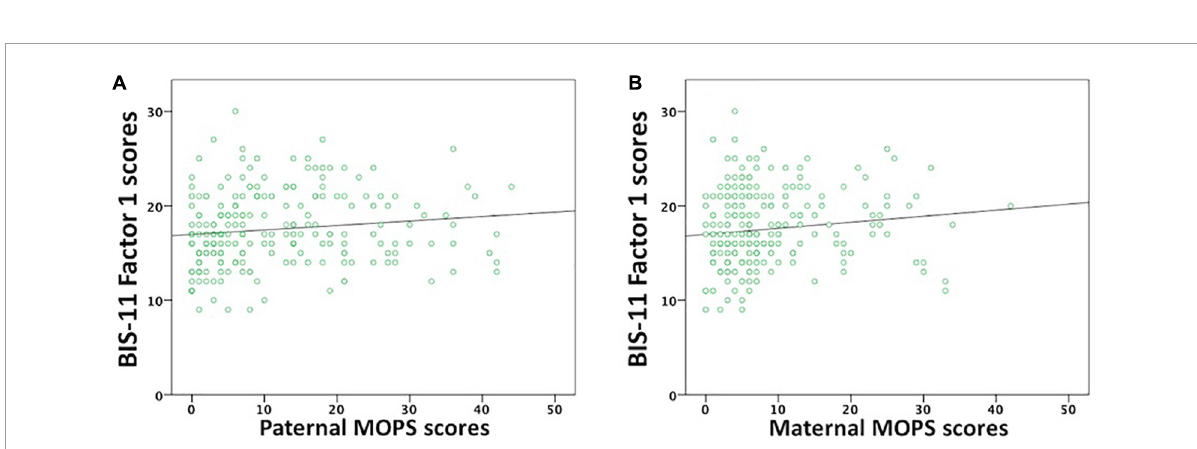
FIGURE2 Correlations between BIS-11 cognitive/attentive (Factor 1) and both Paternal and Maternal MOPS scores. BIS-11 cognitive/attentive scores significantly correlated with (A) Paternal MOPS scores, but not with (B) Maternal MOPS scores.